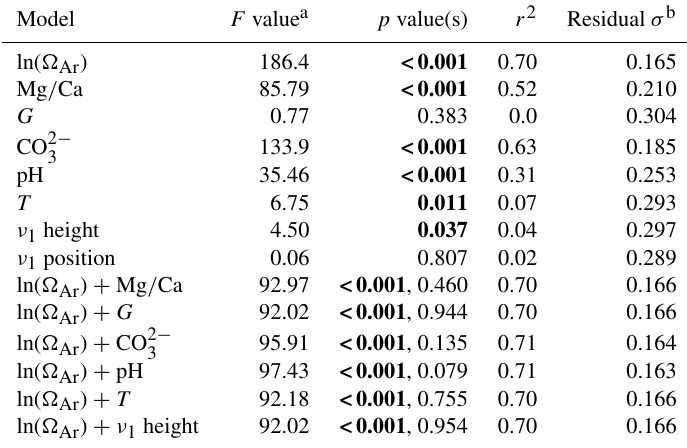
Table 1. Linear model statistics for fits to ν 1 FWHM.